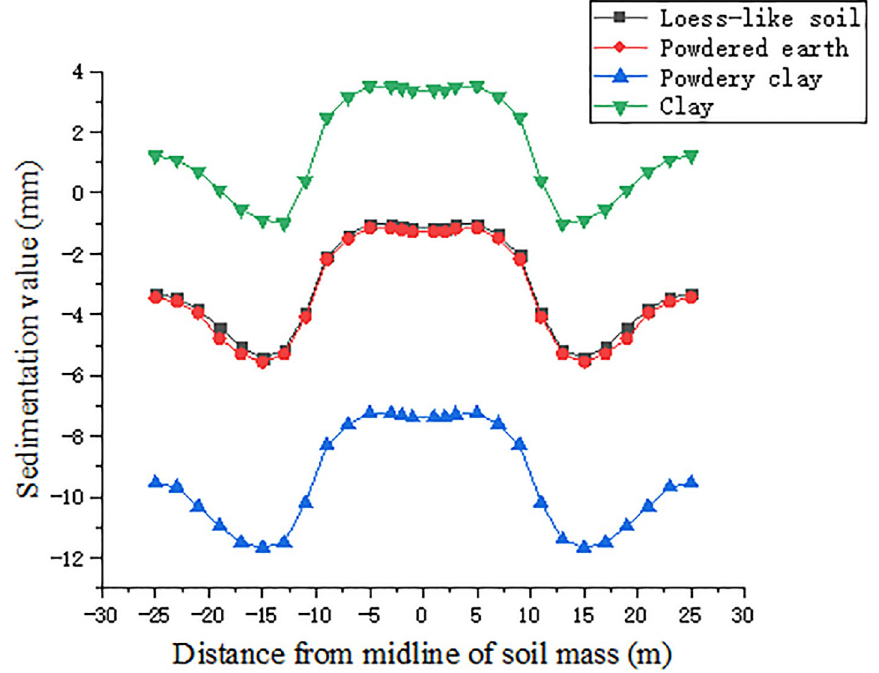
Fig 18. Longitudinal deformation curves of four soil surfaces jacked up to 5m.